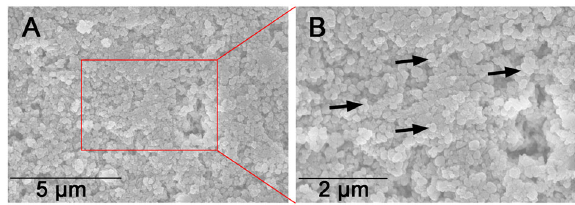
Fig. 5 SEM images of representative morphologies of non- fi red LDGC